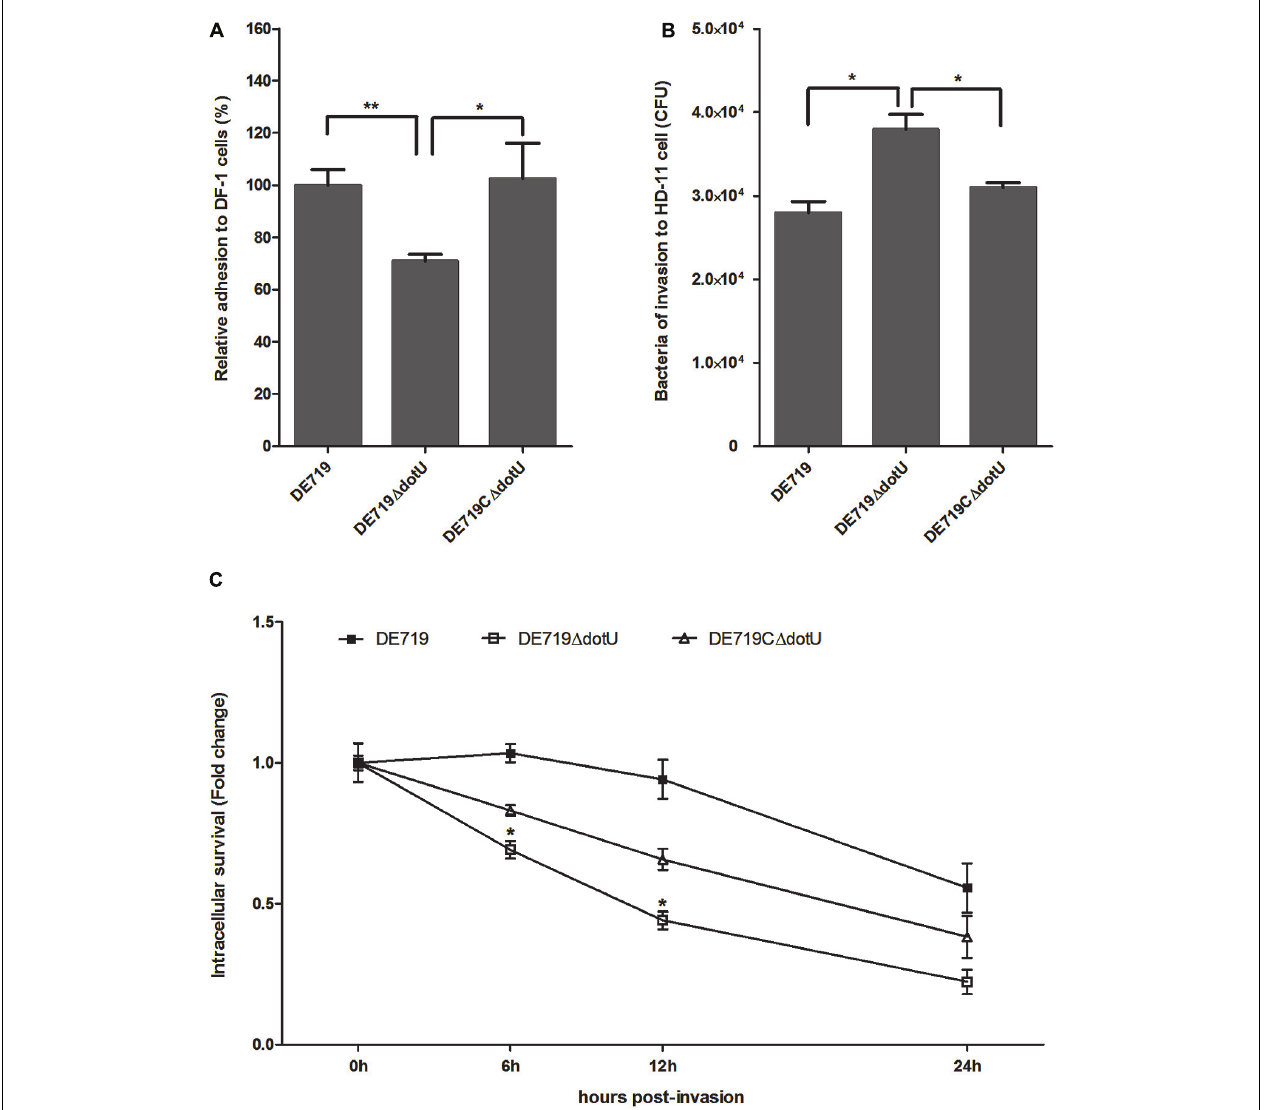
FIGURE 4 | Bacterial adhesion, invasion, and intracellular survival assays. (A) Adhesion assays performed on DF-1 cells.Values are average of three independent experiments. Error bars indicate standard deviations. One-way ANOVA was performed for statistical significance. ** p < 0.01; * p < 0.05. (B) Invasion assays with chicken macrophage HD-11 cells.Values are average